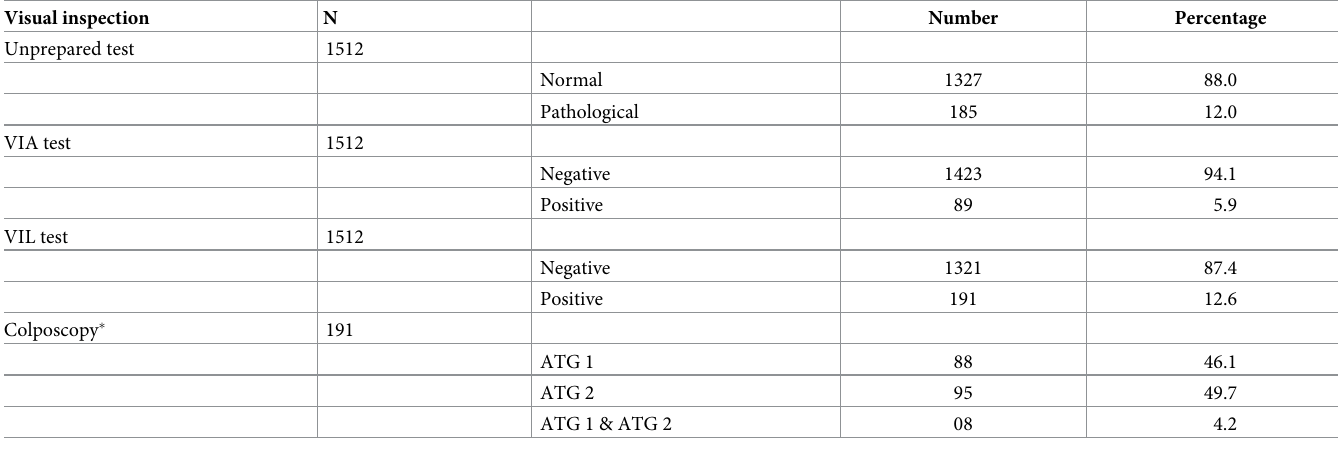
Table 2. Distribution of women according to different types of tests.